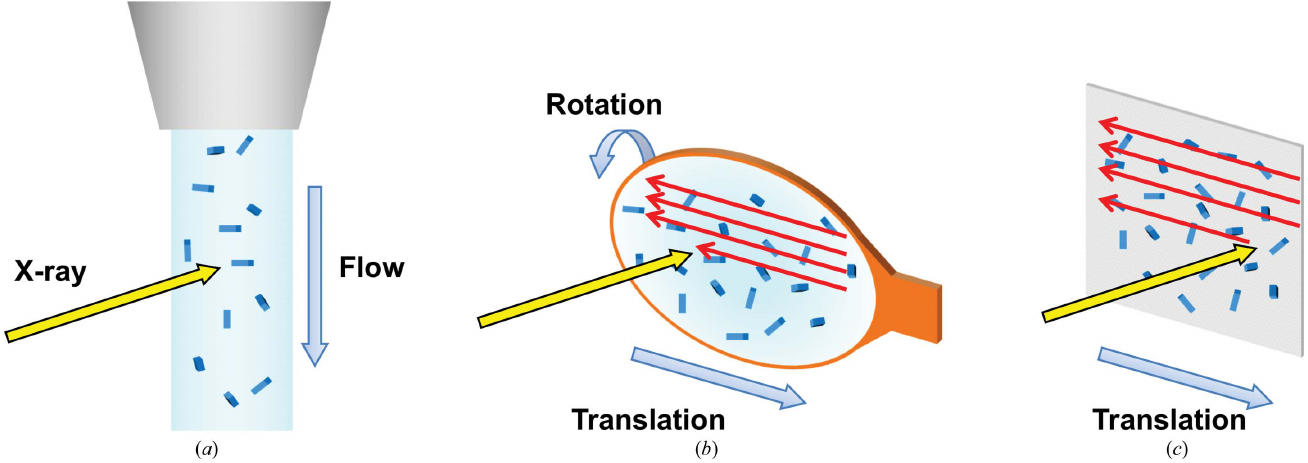
Figure 7 Various sample-delivery methods for serial synchrotron crystallography. ( a ) Liquid stream of a crystal suspension (Botha et al. , 2015; Nogly et al. , 2015), ( b ) loop-harvested cryocooled microcrystals (Gati et al. , 2014; Hasegawa et al. , 2017) and ( c ) thin-film substrate on which microcrystals are loaded (Coquelle et al. , 2015).